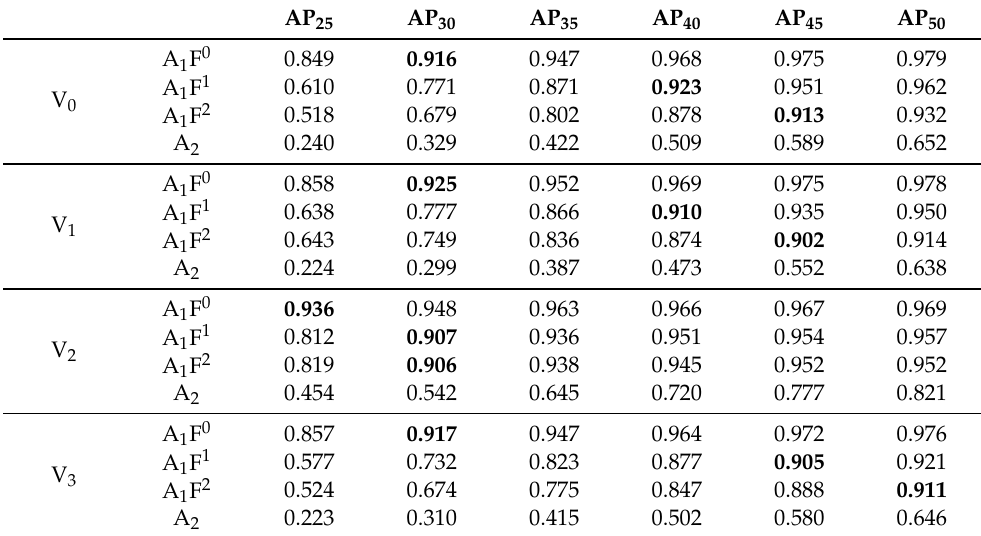
Table 7. Average precisions at different thresholds for MI. Bold: First algorithm’s AP ≥